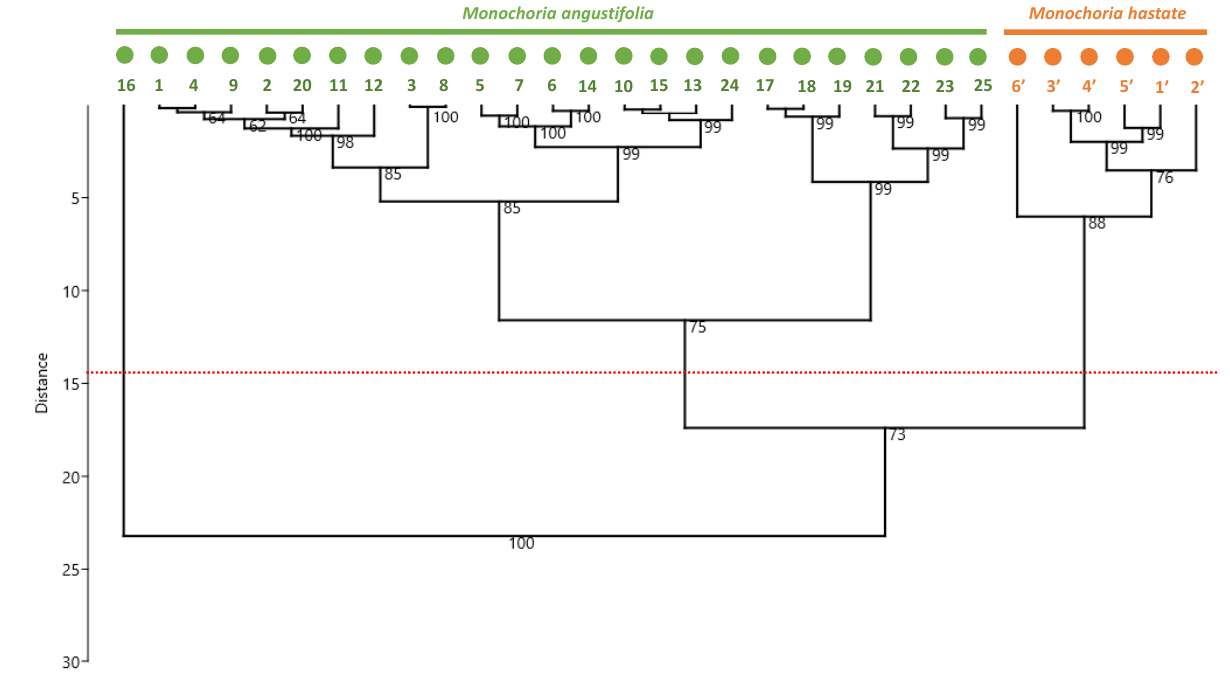
Figure 6. Hierarchical clustering analysis (HCA) of 25 different populations of M. angustifolia and 6 different populations of M. hastata on the basis of their phytochemical profiles. The percentages of replicate trees which associated samples cluster together in after bootstrap analysis (percentage of 5000 replicates) are shown next to the branches.